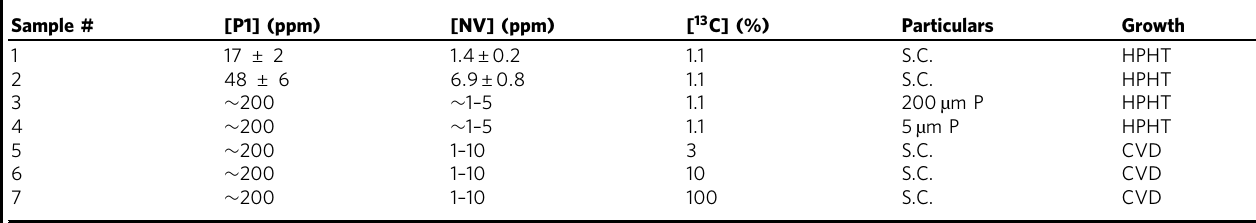
Table 1 Summary of samples and de fi ning characteristics. We consider single-crystal (S.C.) samples both at natural abundance and with 13 C enrichment, as well as diamond particulate (P)